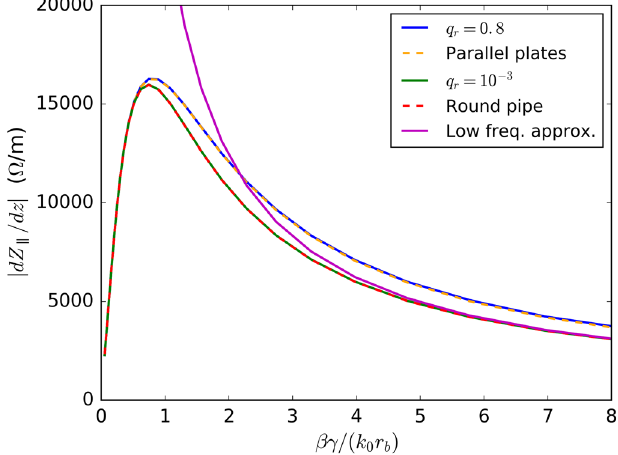
FIG. 2. Dependence of space charge longitudinal impedance with wave number. Comparison between Eq. (12) and analytic solutions for parallel plates and circular pipe with r b ¼ 5 mm, b 1 cm, and β ¼ 0 . 5 e ¼